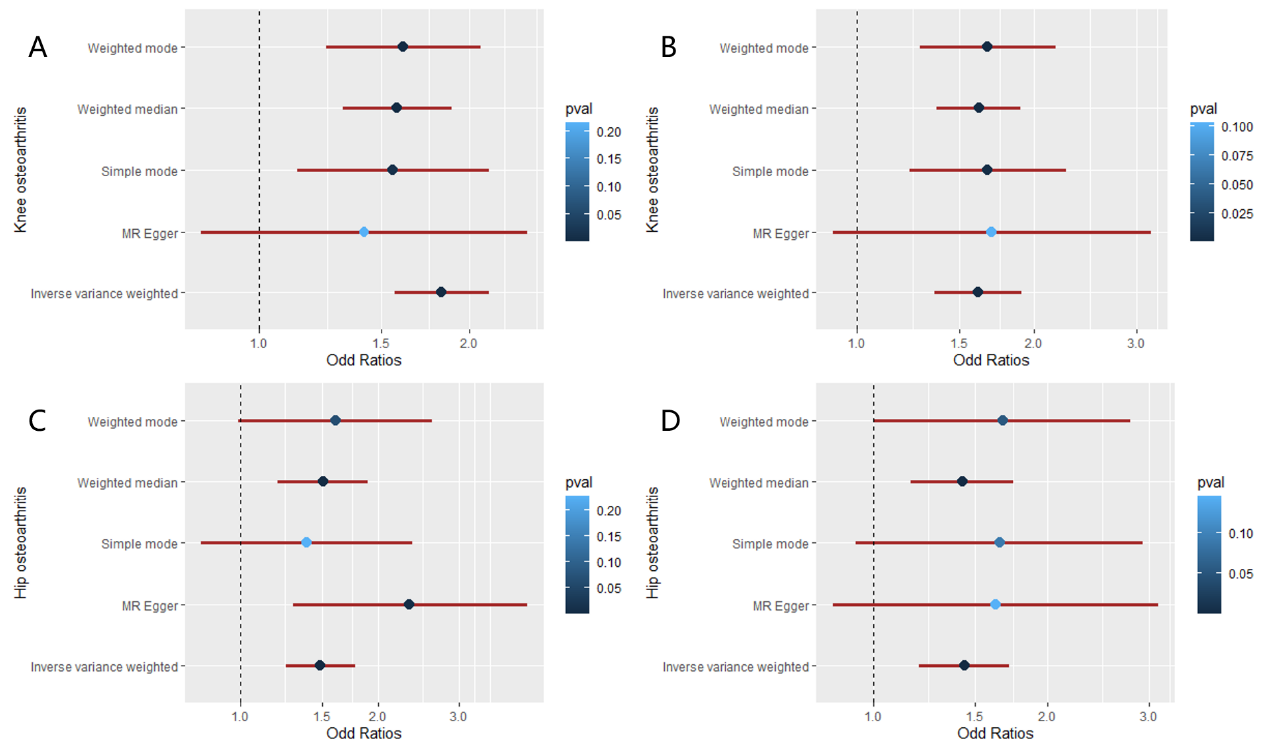
Figure 4. The forest plot about the causal effects of WC and HC on osteoarthritis. ( A ) Forest plot of the casual effect of WC on KOA. ( B ) Forest plot of the casual effect of WC on HOA. ( C ) Forest plot of the casual effect of HC on KOA. ( D ) Forest plot of the casual effect about HC on HOA. (WC: waist circumference; HC: hip circumference; KOA: knee osteoarthritis; HOA: hip osteoarthritis; OR: odds ratio).